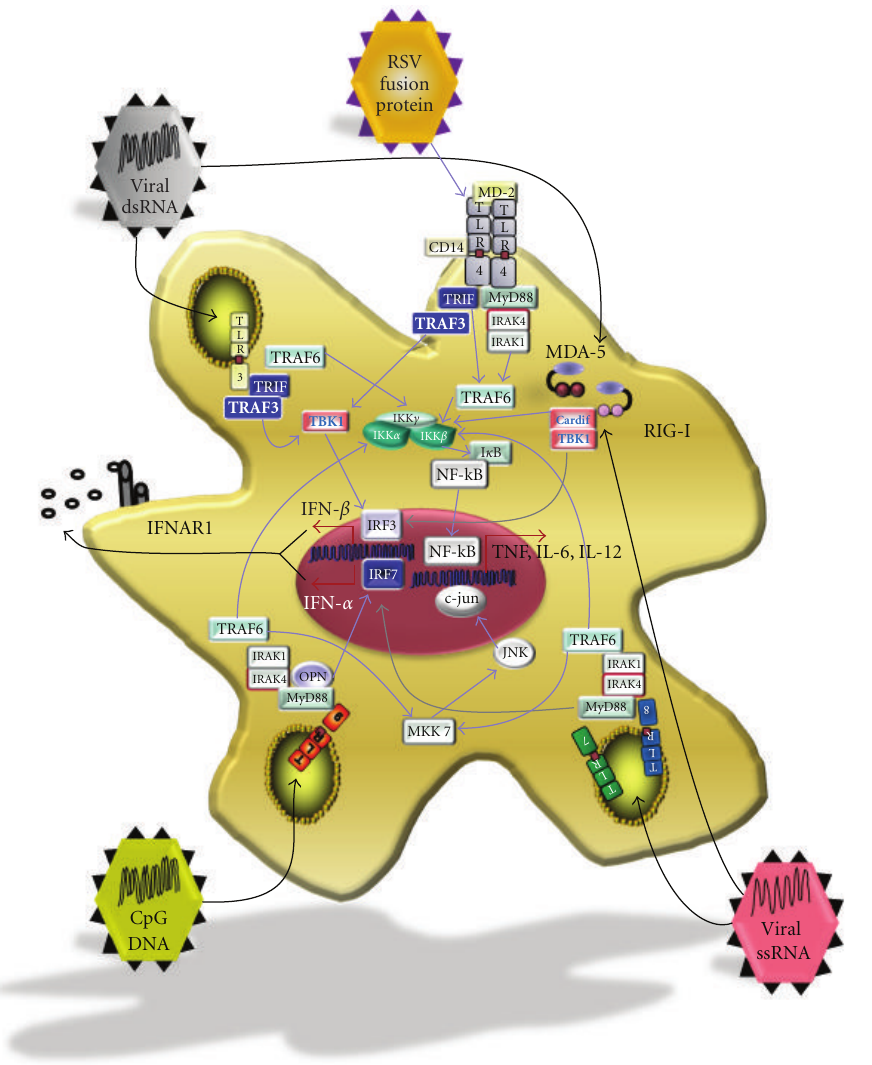
Figure 2: Pathogen recognition systems . The innate immune system senses viral pathogens by recognizing distinct pathogen-associated molecular patterns (PAMPs) using various pattern recognition receptors (PRRs). Two of the best-characterized virus-sensing PRRs include member of the Toll-like receptors (TLRs) and retinoic acid inducible gene-I- (RIG-I-) like receptors (RLRs) families. These PRRs couple the recognition of viral PAMPs to the induction of proinflammatory cytokines through various signaling cascades. The cytosolic RNA helicase receptors MDA5 and RIG-I initiate the cascade by recruiting the Cardif/TBK1 complex after sensing viral RNA. This activates the kinase TBK1 to phosphorylate interferon regulatory factor (IRF)-3 and IRF7, resulting in their nuclear translocation and the transcription of IFN α / β . The cell surface receptor TLR4, in partnership with CD14, couples the recognition of respiratory syncytial virus fusion protein [78] to cytokine induction by signaling through the MyD88-dependent as well as the MyD88-independent pathways. The endosomal TLRs, TLR7, TLR8, and TLR9 also signal through MyD88 to activate inflammatory cytokines such as TNF, IL-6, and IFN- α / β . The other endosomal TLR (TLR3) signals through the MyD88-independent pathway via the TIR domain-containing adaptor molecule TRIF. Via TRIF, TLR3 signaling can activate NF-kB using TRAF6, and in addition, can induce type I IFN expression probably via TRAF3, TBK1, and